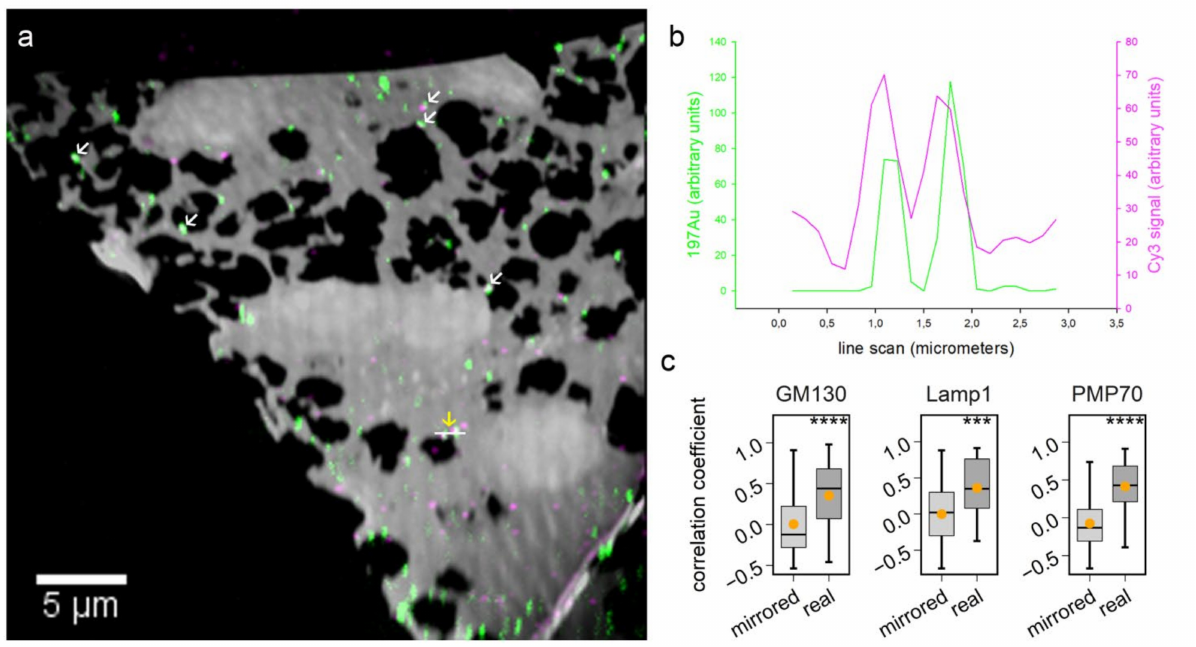
Figure 4. Correlation of 6 nm Au_Np detected by nanoSIMS and fluorescence signals detected by fluorescent microscopy. ( a ) Overlay of gold images and fluorescent images for targeting PMP70. Examples of colocalized gold and fluorescent signals are indicated by white arrows. The signal variations of gold and Cy3 along the area indicated by a white horizontal line were extracted and plotted in ( b ). ( c ) shows the correlation coefficient between gold and fluorescent images (real) in comparison to that between gold and mirrored fluorescence images (mirrored). Wilcoxon rank sum test: for GM130, lamp1 and PMP70, N = 51, 45 and 50, respectively, and p = 4.9 × 10 − 5 , 1.3 × 10 − 4 and 1.9 × 10 − 9 , respectively. *** p ≤ 0.001, **** p ≤